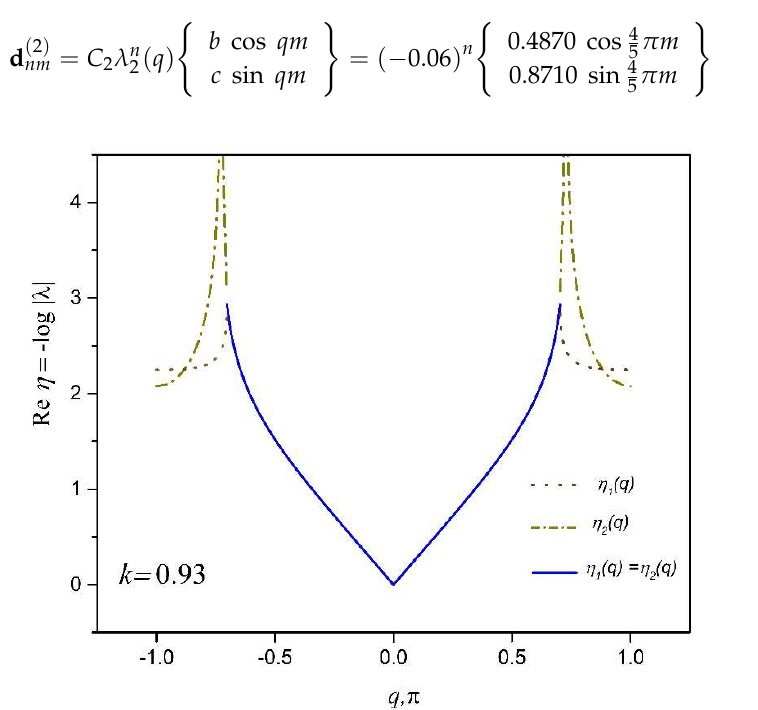
Figure 4. Deformation decay spectrum for an x-braced lattice (Figure 1) at 𝑘 = 0.93 .